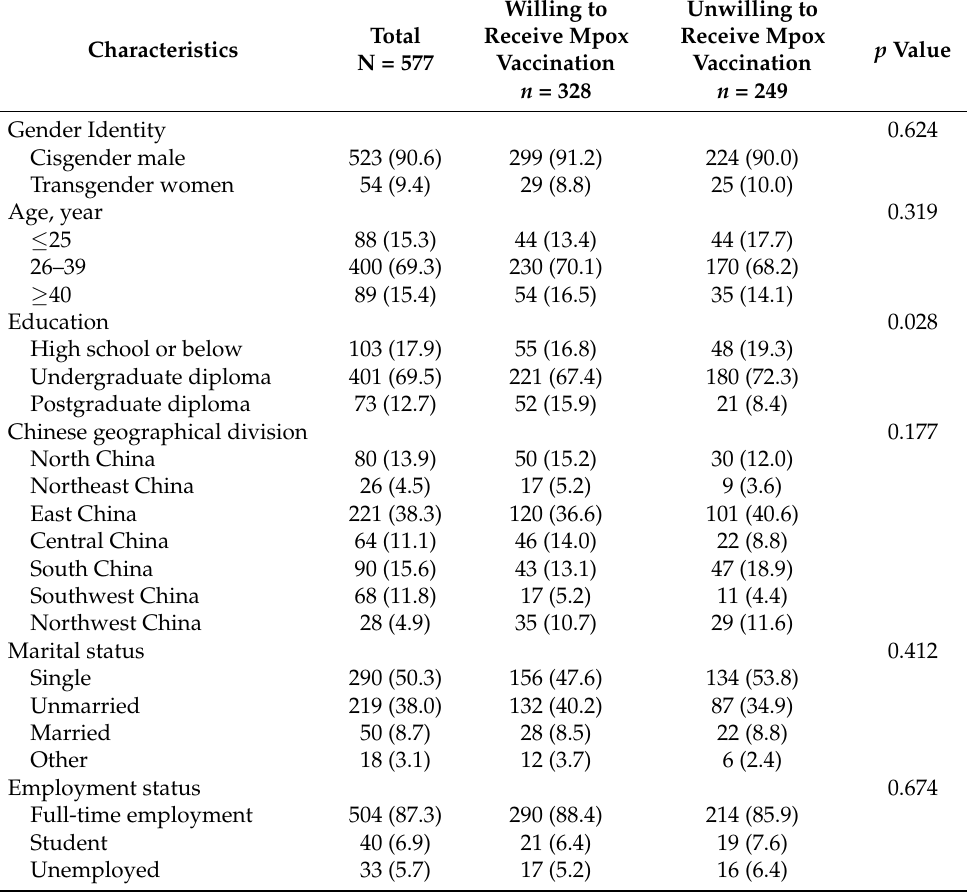
Table 1. Demographic characteristics of MSM living with HIV in